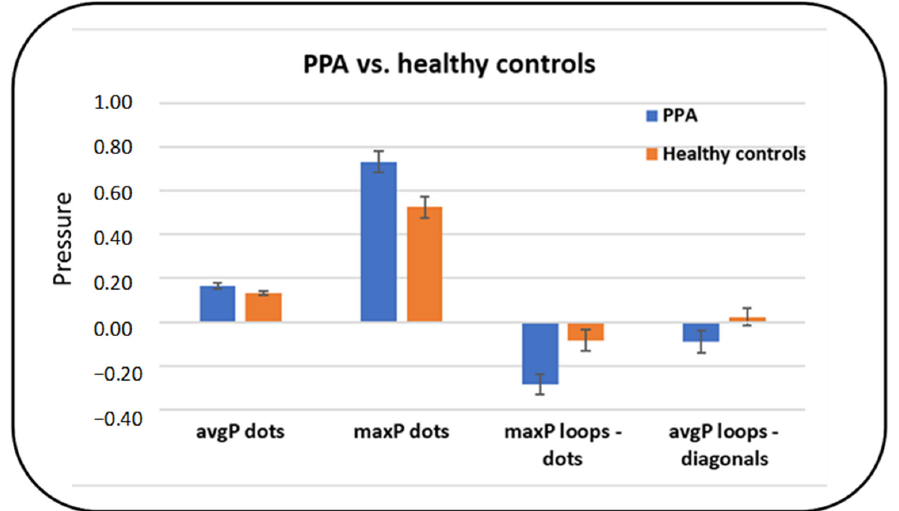
Figure 2. Differences in average and maximum writing pressure between patients with PPA and healthy controls.